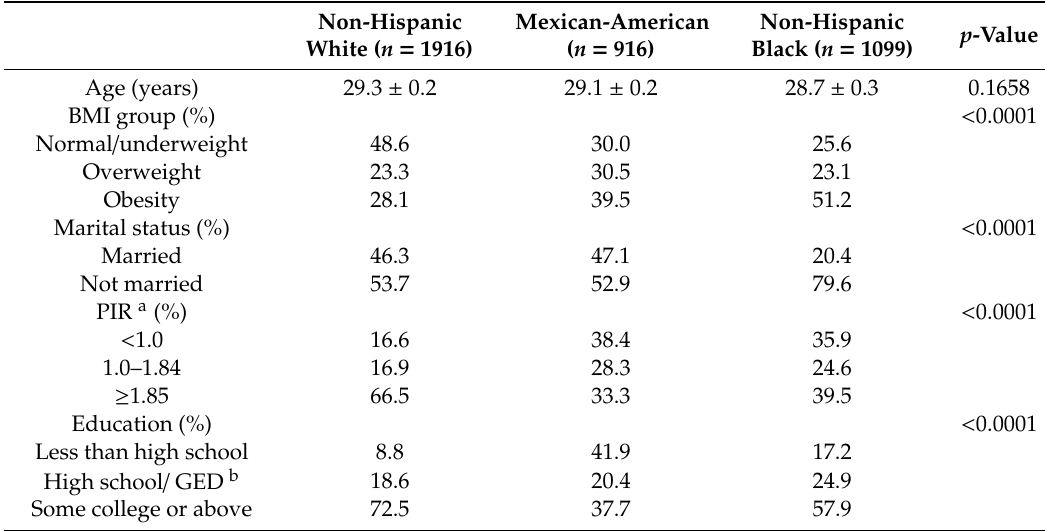
Table 1. Demographic information among women aged 19–39 years by racial / ethnic groups, NHANES 2003–2014 * ( N = 3931). Non-Hispanic Mexican-American White ( n = 1916) ( n =